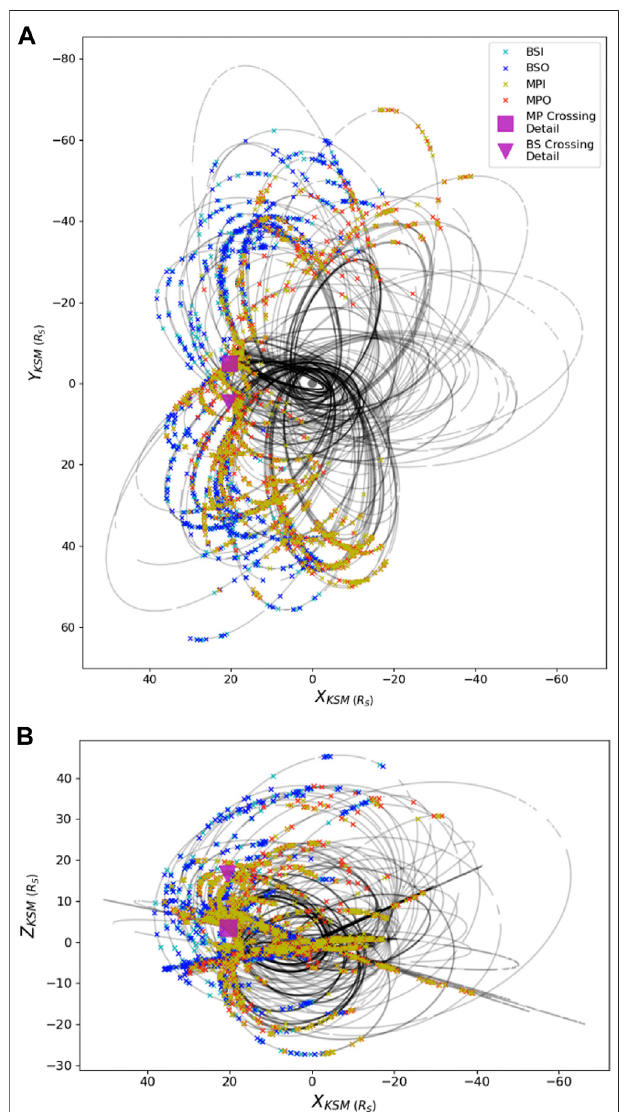
FIGURE 1 | Depiction of Cassini ’ s orbits spanning 1 November 2004 (the end of the fi rst capture orbit) through 15 September 2017 along with associated labeled boundary crossings in the X-Y KSM plane (A) and X-Z KSM plane (B) . The legend refers to the color denoting the four types of crossings in the data set: bow shock inbound (BSI, cyan), bow shock outbound(BSO, blue), magnetopause inbound (MPI, yellow) and magnetopuase outbound (MPO, red). The magenta box and triangle highlight casestudyMPandBScrossings,whichwerefullyencapsulatedinthetestset and occurred on 3 May 2008 and 8 March 2008, respectively. These case studies are highlighted in Figure 2